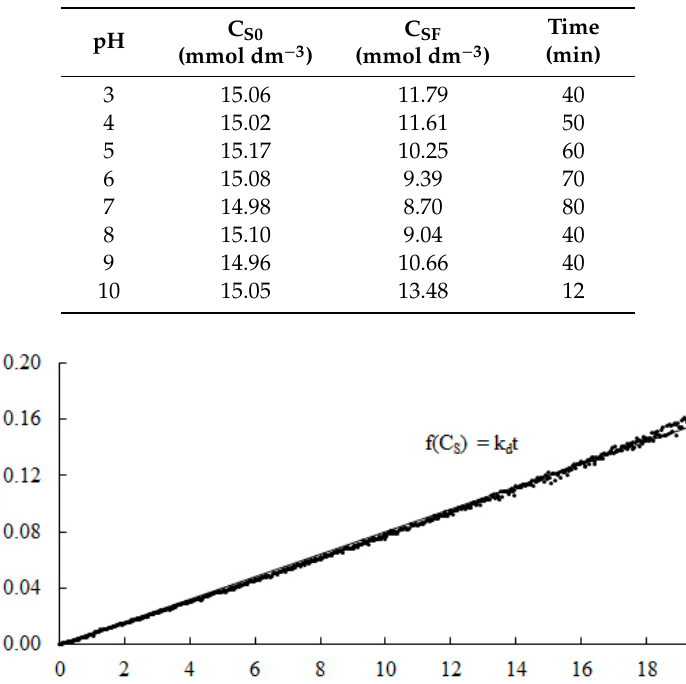
Figure 3. The effect of the pH of the reaction medium on the rate constant of deactivation during the enzymatic process. Error bars represent standard deviation mean of three replicates whilst means with the same letters in the same observation are not significantly different at 0.05 level of the LSD test. So far, no one has presented research on the effect of pH on deactivating bovine liver catalase for the H 2 O 2 decomposition reaction. In the literature, the deactivation constant can only be found for pH 7. The value of the constant k d determined by the presented method for this pH is 7.85 dm 3 mol − 1 min − 1 and is ca. 13% and 6% lower than those determined by Deluca et al. [26] and Feuers et al. [25]. For known values of the enzyme deactivation rate constant (k d ) and Δ C S , based on Equation (12) the reaction rate constants k were determined. The reaction rate constant was also calculated using the Aebi method [30], based on the results of the decrease in the substrate concentration during the first minute of the experiment. The calculation results for both methods are presented in Figure 4.